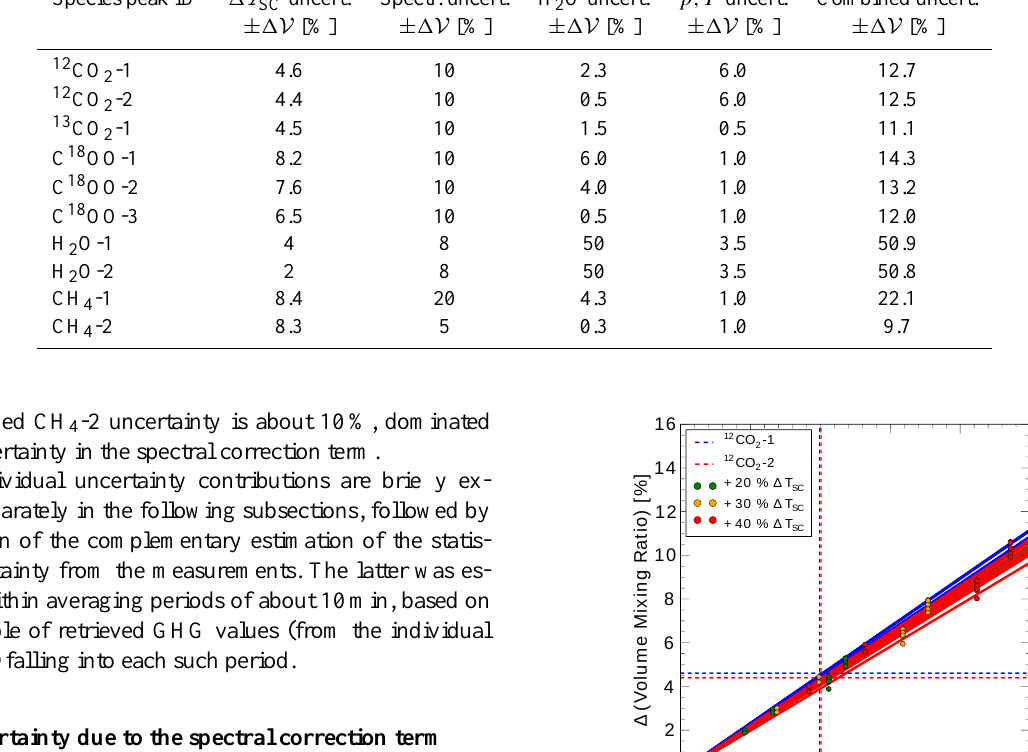
Table 6. Estimated uncertainties (cid:49) V in retrieved GHG volume mixing ratios V , for the 10 selected species absorption lines. The estimates include uncertainties in V due to spectral-correction-term uncertainty, spectroscopic uncertainty, water vapor uncertainty, and pressure and temperature uncertainty. The resulting combined uncertainty is shown as well. Species peak ID (cid:49) T SC uncert.